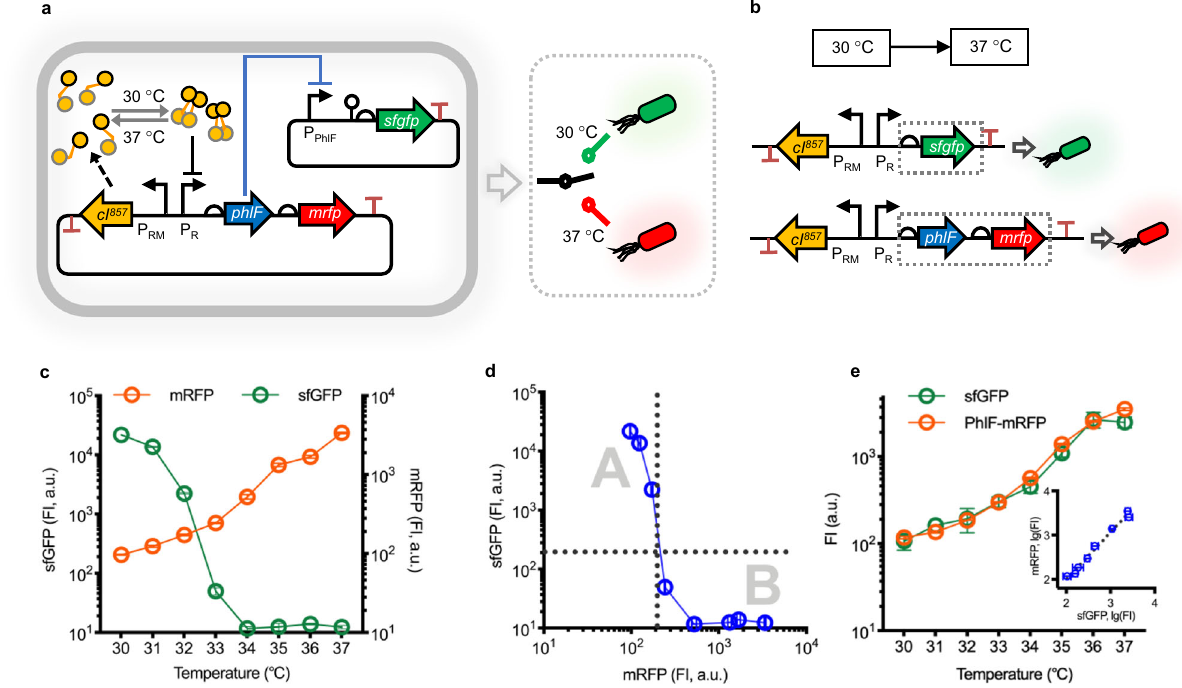
Fig. 1 Design and characterization of thermosensitive bifunctional bio-switch (T-switch). a Circuits of T-switch using a NOT gate design enables bifunctional gene expression, of which the input is the repressor PhlF related to a temperature-controlled system based on cI 857 ( cI ), and the output is a reporter sfgfp encoding sfGFP under the promoter P phlF . Another output is a reporter mrfp encoding mRFP placed downstream the phlF gene ( phlF-mrfp ) for achieving bifunctional control of gene expression. b Promoter activity and orthogonality of the CI 857 -regulated panel are characterized based on two expression cassettes: sfgfp as a reporter alone in a and phlF-mrfp cluster. c Data generated using the constructs from part a via cytometry analysis are used to characterize the bidirectional temperature-response functions of the T-switch. d Data gathered onto a single transfer function between two reporters, namely, sfGFP and mRFP, are identical to those shown in c from the same experiments. Each point represents a condition of cultural temperature from 30 ℃ to 37 ℃ . e The fl uorescence intensity was measured from each temperature from 30 °C to 37 °C for controlling the expression levels of sfgfp and phlF-mrfp . The fl uorescence ratios between sfGFP and mRFP expression from each temperature point collapse onto a single function for linear regression analysis with R 2 = 0.9868 and slope close to 1 (1.065), which was plotted in log-log coordinates (log 10 ). Data are presented as mean ± s.d. of three replicates. FI, Fluorescence Intensity in arbitrary unit